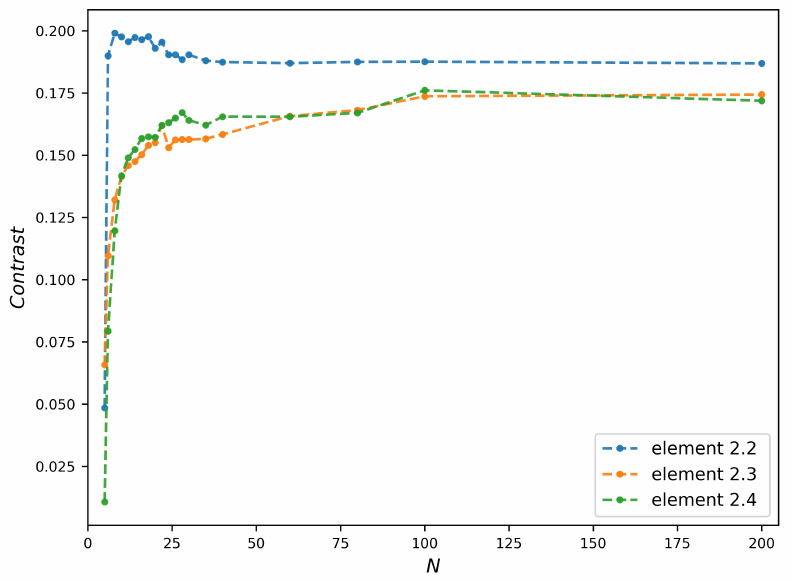
Figure 7. Contrast plots of different width bars versus number of zones N :the images are simulated under the same conditions of Figure 4, the studied bars of test chart are shown in Figure